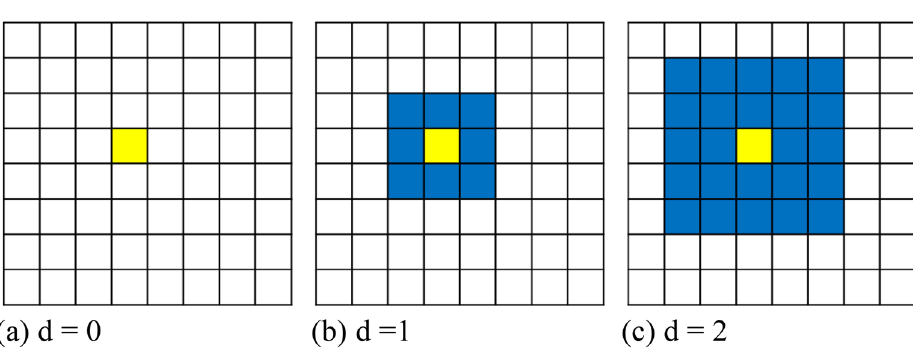
Figure 4. Algorithm for computing the anomaly score for a given query patch image, along with illustrations of the effect of the path distance parameter. The yellow cell indicates the location of a query patch image, and the blue cells refer to the locations of the adjacent reference normal patch images considered in measuring the similarity score with the query patch image, with the reference patch image being at the same location as the query patch